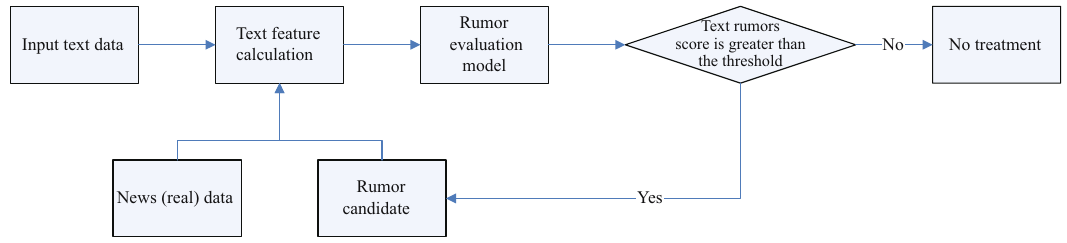
Figure 3: Detection process of rumor information in news media and fi lm and